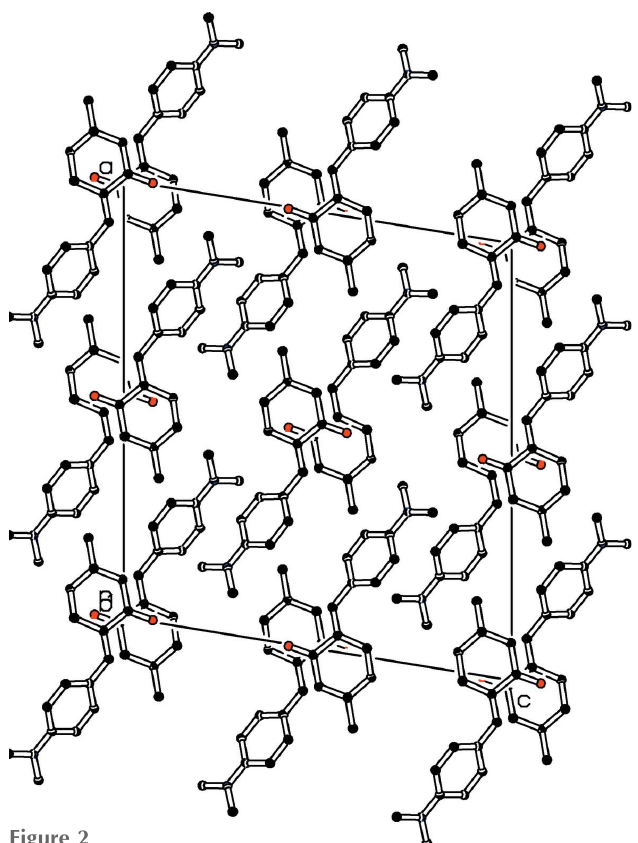
Figure 2 The packing viewed down